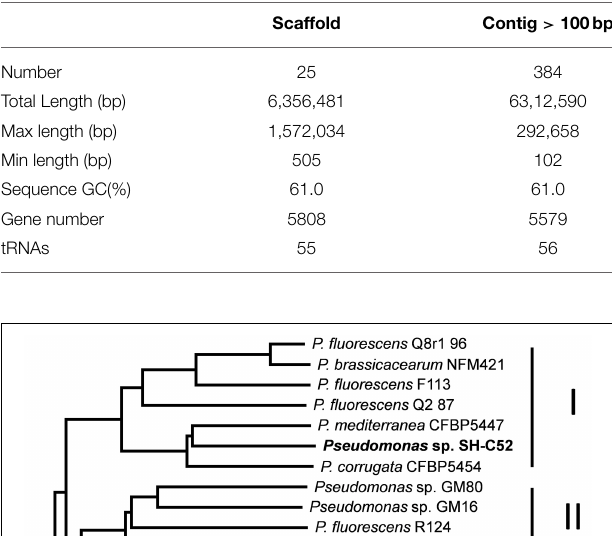
TABLE 1 | General genome sequence information of Pseudomonas sp. SH-C52.